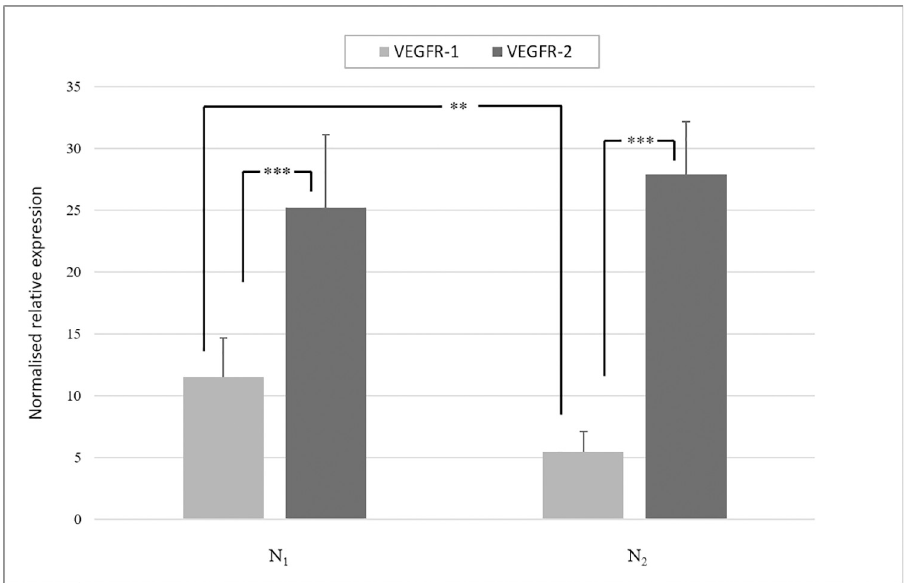
Fig 1. Gene expression of VEGFR–1 and VEGFR–2 in HD1 and HD2. Median and standard error of gene expression of VEGFR–1 and VEGFR–2 at all points of investigation in native ECs of HD1 and HD2 are shown. VEGFR–2 was expressed significantly higher than VEGFR–1 in N 1 and N 2 ( p < 0.001). Between the two batches, VEGFR–2 was expressed equally, whereas VEGFR–1 was expressed significantly higher in HD1 than in HD2 ( p < 0.01). Statistical analysis was carried out using Mann–Whitney U test for unpaired data. � p < 0.05, �� p < 0.01, ��� p < 0.001. bottom of the cell culture in stage 6 (Fig 2C). In contrast, native cells of HD2 displayed a lower cell density in the beginning of cultivation and less sprouting activity (Fig 3A). Therefore, more linear side–by–side arrangement was observed. By the networking of linearly arranged cells, N entered stage 4 at day 18. Finally, cells of HD2 reached stage 6 after 25 days of cultiva- 2 tion (Fig 3B and 3C). For quantification of angiogenesis in vitro , mean values and standard deviations of sums of assigned stages of angiogenesis (S) were evaluated and compared by using one–way ANOVA and Dunn–Bonferroni post hoc test. N reached a value of S N 1 = 1 56.9 ± 4.3 and N of S N 2 = 50.5 ± 6.5. By comparing the values between the batches, it was 2